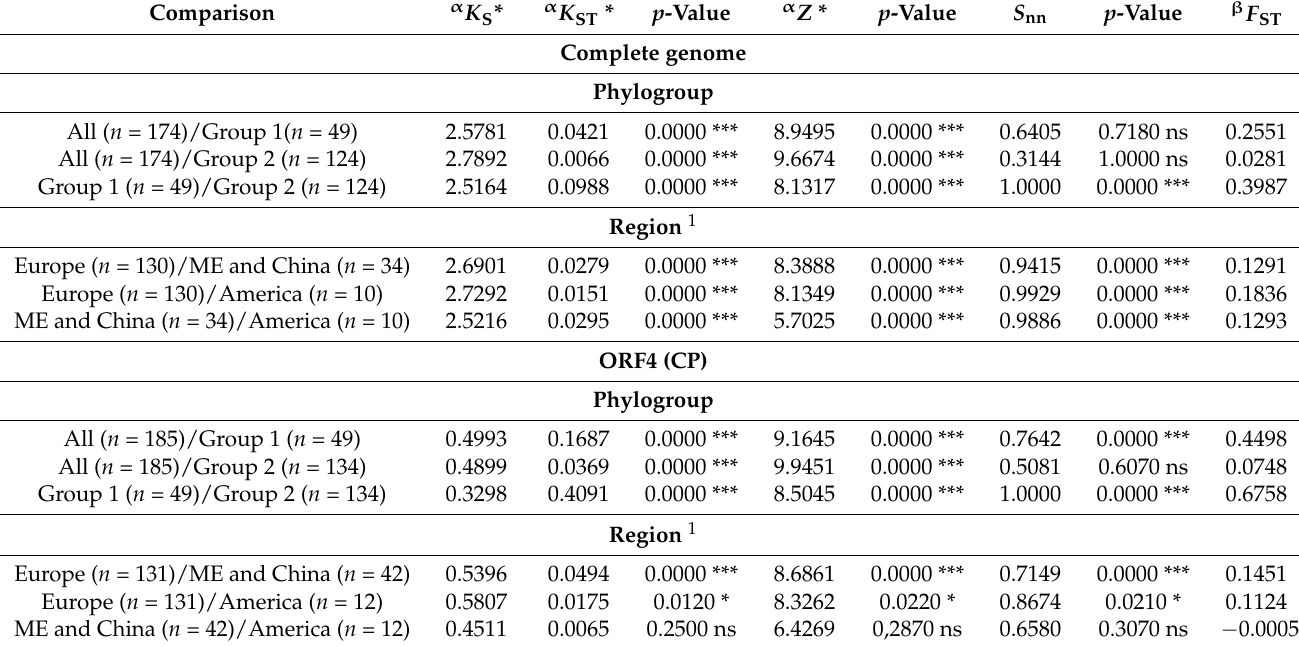
Table 3. Genetic differentiation estimates for lineages of ToBRFV, based on the complete genome and CP gene sequences comparison.